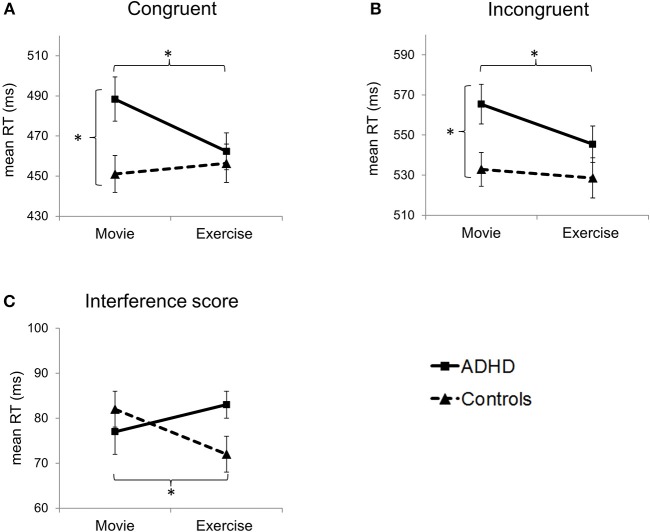
Effects of group and condition on primary outcome measures: reaction times (RT) in (A) congruent and (B) incongruent trials, and (C) interference score. Error bars represent standard errors of the mean. *p < 0.05 (refers to pairwise comparisons, i.e., paired-t tests and two-sample t-tests).